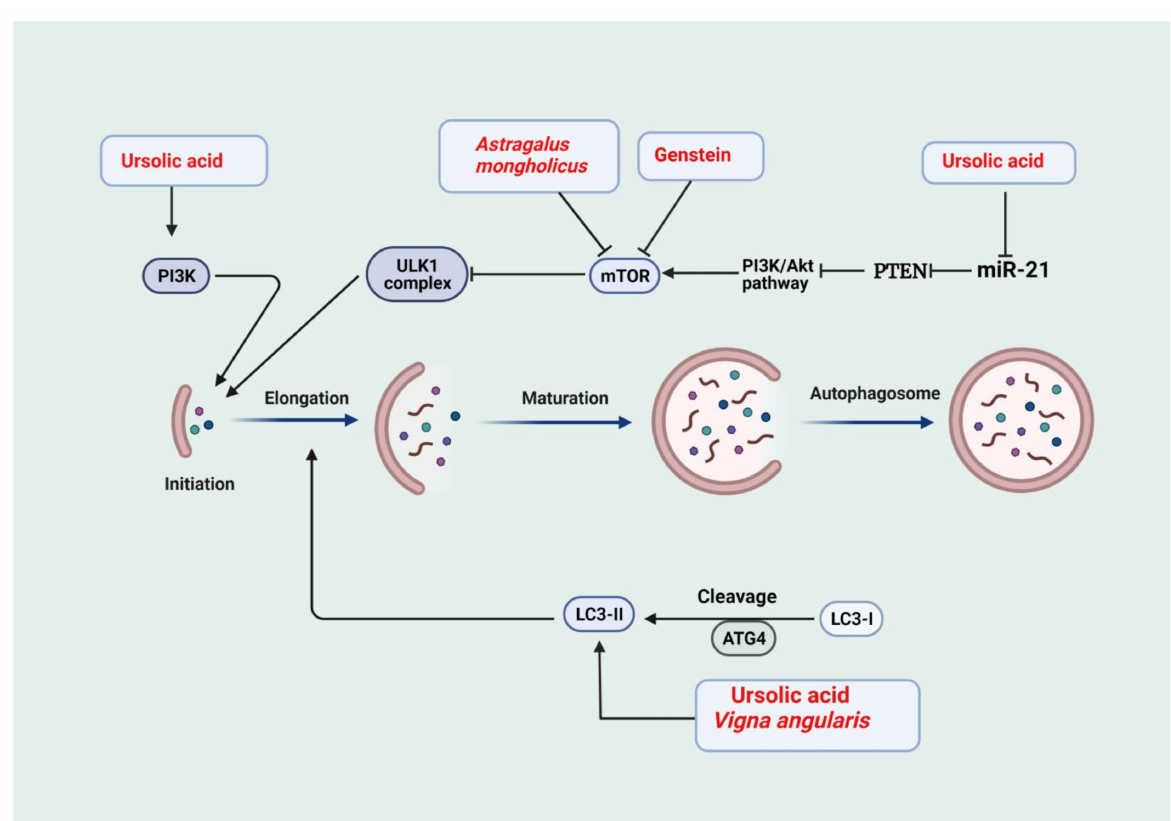
Figure 2. Medicinal plants and bioactive compounds that activate autophagy. The phosphatidylinositol-3-kinase (PI3K)/Akt and the mammalian target of rapamycin (mTOR) (PI3K/Akt/mTOR) pathway is a negative modulator of the Unc-51-like kinase 1 (ULK-1) com- plex. Activation of phosphoinositide 3-kinase (PI3K) and ULK-1 complex is required for initiation. Light chain 3-I (LC3-I) is cleaved to light chain3-II (LC3-II) to drive the elongation phase. This is followed by maturation to form the autophagosomes. Phosphatase and tensin homolog (PTEN) is a negative modulator of the PI3K/Akt/mTOR pathway, and microRNA-21 (miR-21) inhibits PTEN. Ursolic acid activates autophagy through inhibition of miR-21, thus allowing PTEN to inhibit PI3K/Akt/mTOR pathway, leading to activation of the ULK-1 complex. In addition, ursolic acid activates the PI3K complex. Therefore, ursolic acid is involved in the initiation phase of autophagy. Astragalus mongholicus and genistein inhibit mTOR, leading to activation of ULK-1. Ursolic acid and Vinga angularis drive the formation of LC3-II and the elongation